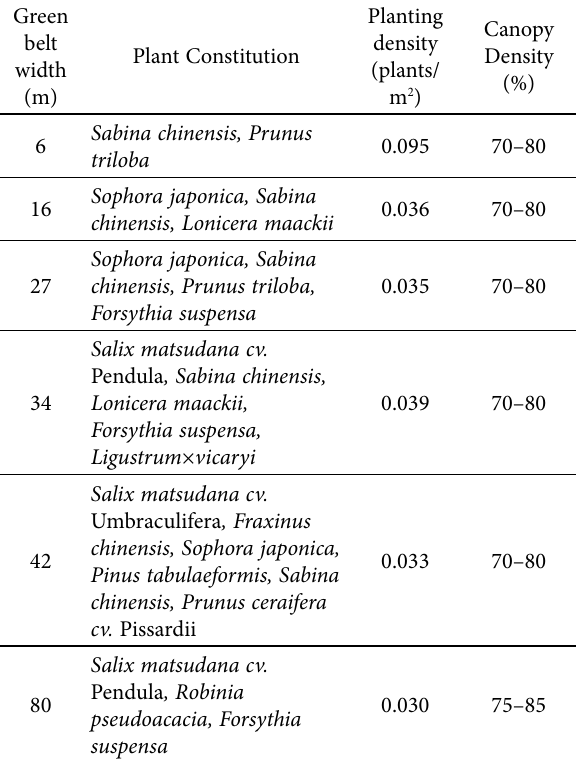
Table 2. Basic characteristics of the six green belts Green belt Plant Constitution width